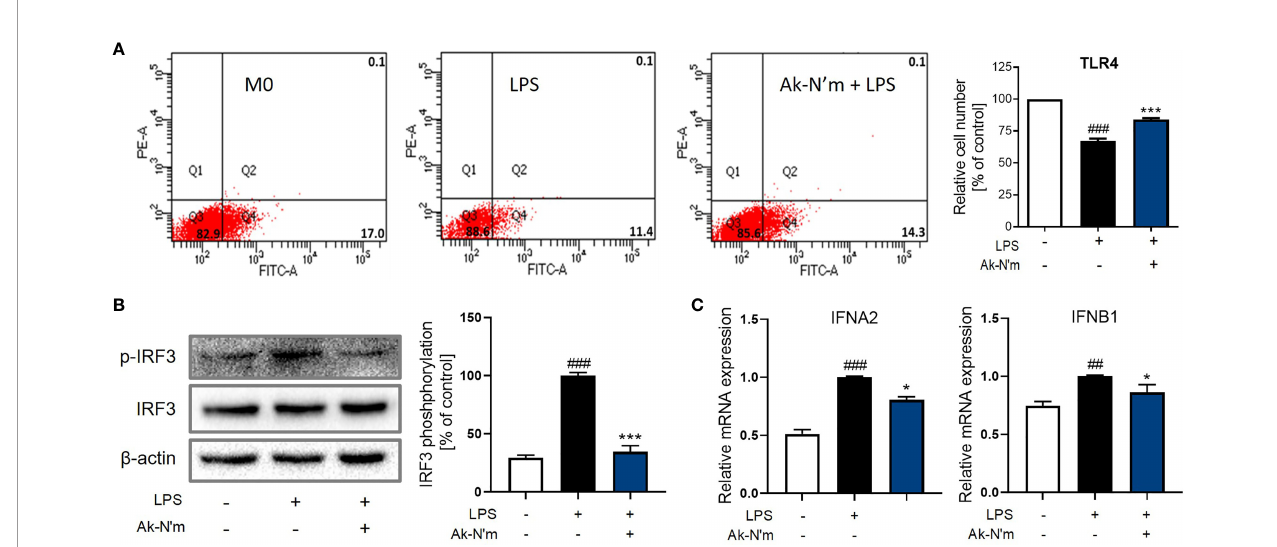
FIGURE 9 | Ak-N ’ m treatment attenuated TRIF-dependent pathway. Ak-N ’ m inhibited the TRIF-dependent pathway in LPS-stimulated macrophages. (A) The endocytosis of TLR4 was attenuated via Ak-N ’ m treatment, where the decrease of surface TLR4 by LPS stimulation was signi fi cantly attenuated by the co-treatment of the peptide. (B) Transcription factor IRF3 was inactivated upon treatment of the peptide. (C) AkN ’ m suppressed the expression of Type 1 interferon genes IFNA2 and IFNB1. Data are presented as mean ± SEM. ## p < 0.01 and ### p < 0.001 represent signi fi cant difference between the negative and positive control. *p < 0.05 and ***p < 0.001 represent signi fi cant difference between LPS-stimulation and co-treatment of LPS and Ak-N ’